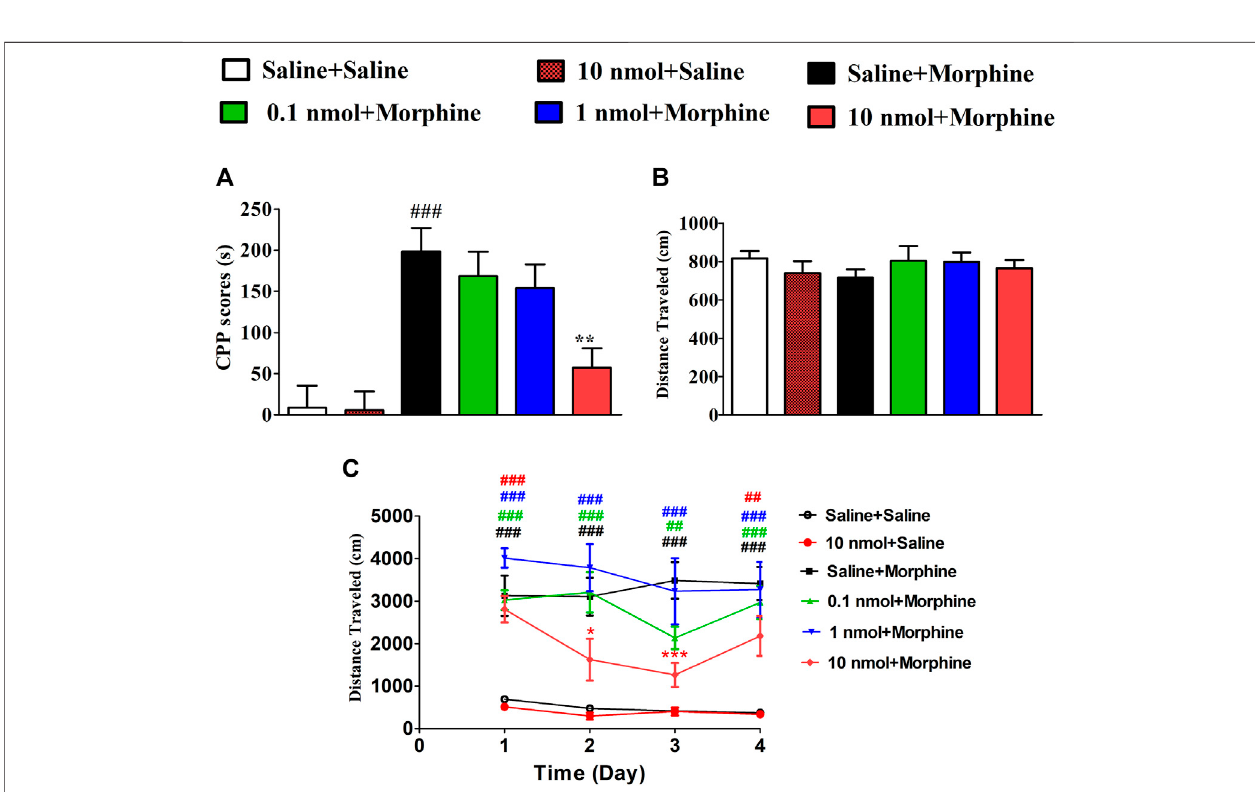
FIGURE5| Effects of α -conotoxin TxIBinacquisition ofmorphine-induced CPP.Resultsareexpressed asmean preference scores ± SEMsfor8 – 10mice. (A) The CPP scores of post-conditioning test, CPP scores (cid:1) the time spent in drug-paired compartment during post-conditioning test — preconditioning. ANOVA for the CPP scores: F 5,47 (cid:1) 10.07, p < 0.001; (B) the distance traveled of post-conditioning test. ANOVA for the distance traveled: F 5,47 (cid:1) 0.53, p (cid:1) 0.75; (C) the distance traveled duringCPPacquisition.#denotesasigni fi cantdifferencefromthesaline+salinegroup;*denotesasigni fi cantdifferencefromthesaline+morphinegroup(** (cid:1) p < 0.01, #### (cid:1) p <